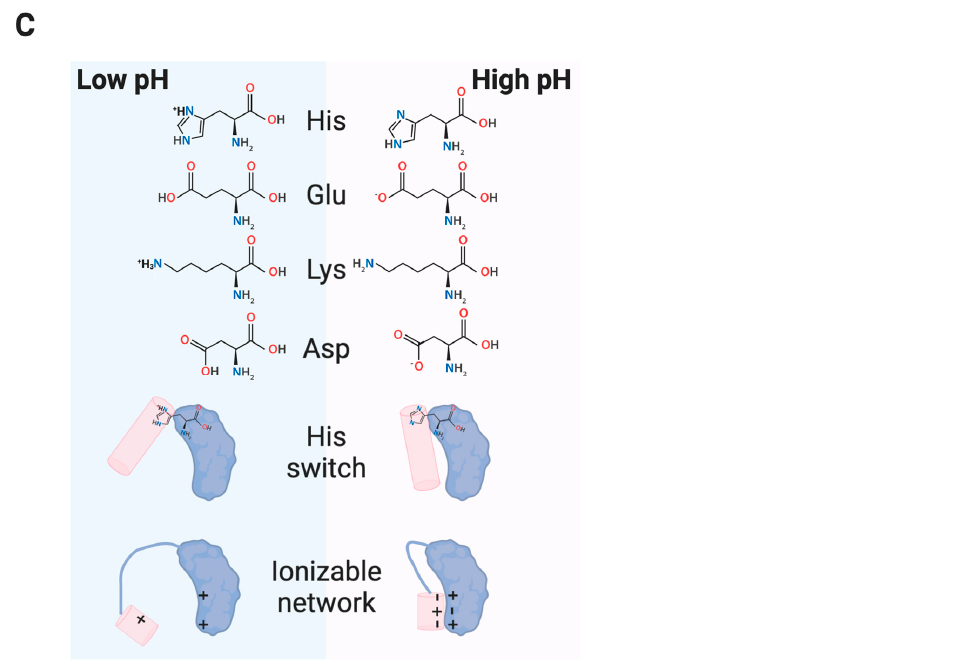
Figure 1. Increased intracellular pH (pHi) in cancer. ( A ) Normal epithelial cells have an intracellular pH (pHi) of 7.0–7.2 while pHi is constitutively increased in dysplastic and metastatic cancer cells. ( B ) Dysregulation of acid loaders (anion exchangers (AE1)) and acid extruders (the sodium proton exchanger (NHE1), monocarboxylate transporters (MCTs), and plasma-membrane resident vacuolar ATPases (V-ATPases) have been linked to the dysregulated pHi in cancer. ( C ) Cellular pH dynamics a ff ect R-group titration of key residues like histidine (His, pKa 6.5) and residues like aspartate (Asp), glutamate (Glu), and lysine (Lys) that can have up- or downshifted pKas depending on protein environment. Changes in protonation of single residues, or networks of ionizable residues can alter protein structure and